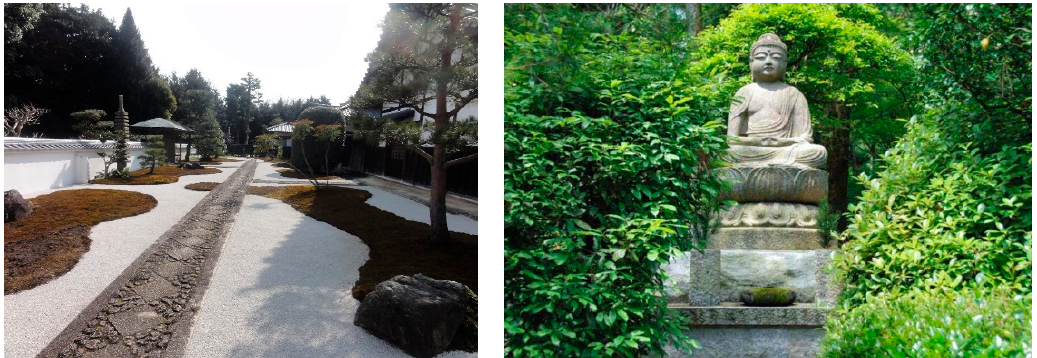
Figure 1. Zen aesthetics in Ry ō an-ji, Tokyo.